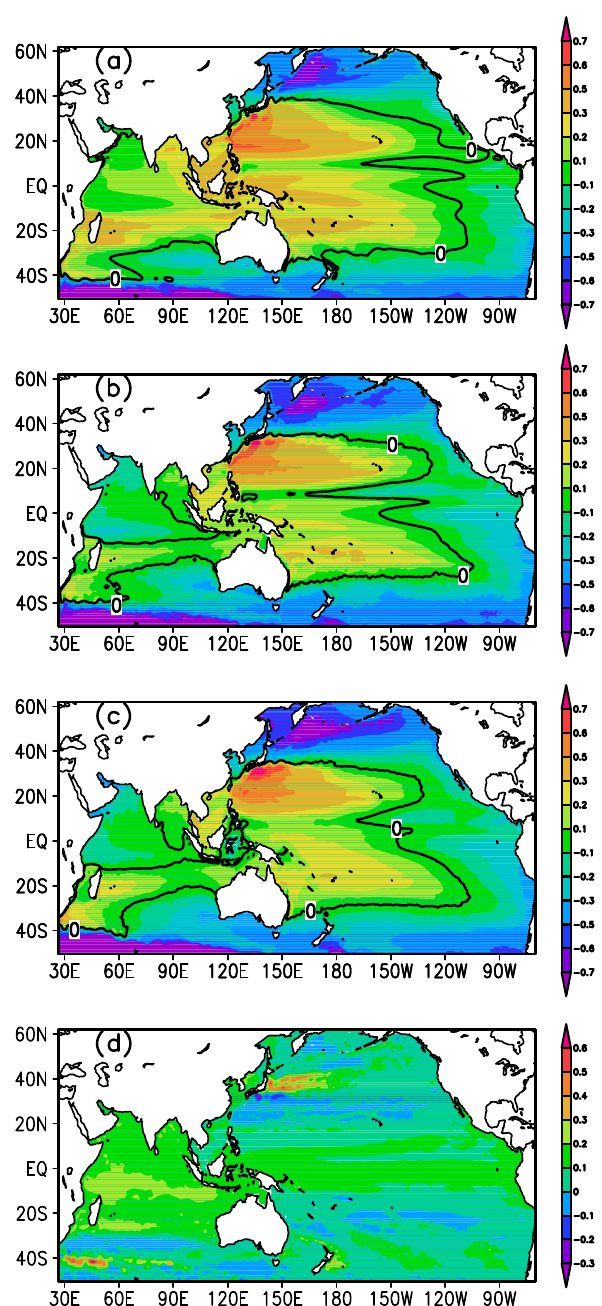
Figure 1. MDTs from a model free run without any data assimi- lation (MDTMOD) (a) , from an assimilation run with in situ data assimilation (MDTTS) (b) , and from the gravimetric data and in situ observations with an offset removed (MDTOBS) (c) . Differ- ence between MDTMOD and MDTTS (d) . Values are given in units of meters. The bold solid line represents isoline